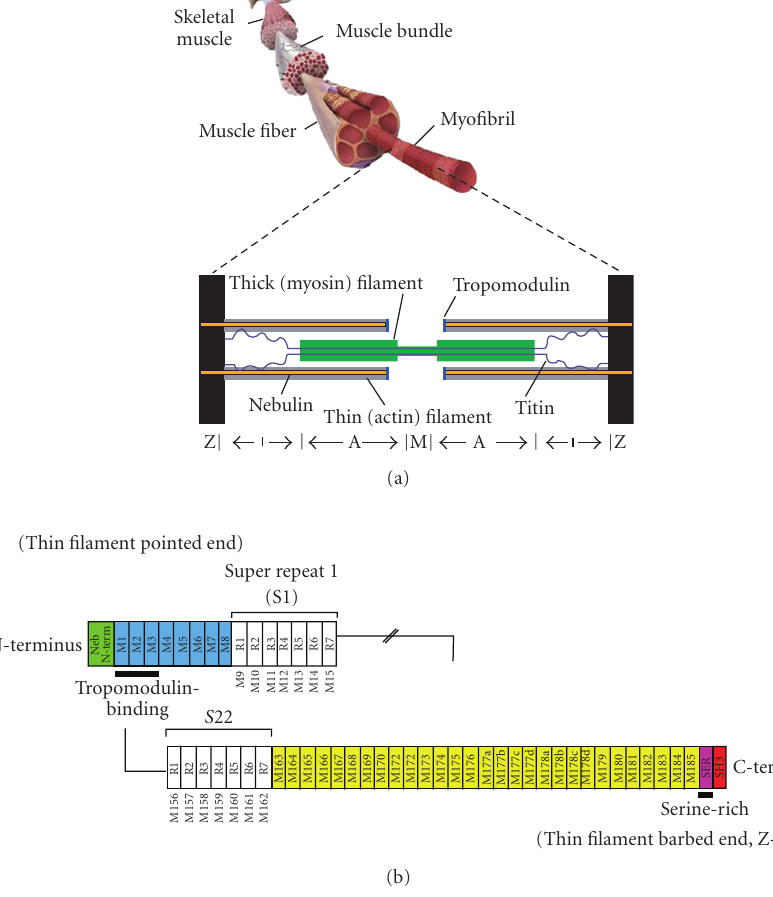
Figure 1: (a) Schematic of the structural organization of skeletal muscle (top) and sarcomere (bottom). (b) Schematic of the human nebulin sequence. Nebulin has a highly modular structure, with, in the central region, (M9–M162) seven modular repeats arranged into twenty-two superrepeats (only two of which are